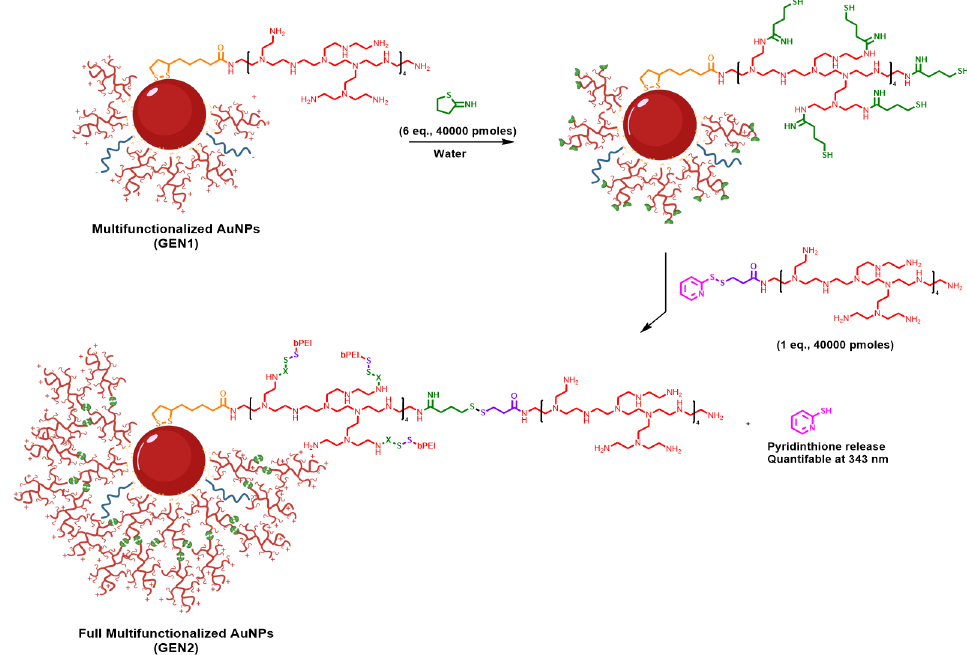
Figure 2. Synthesis scheme of GEN1 AuNPs activation of GEN1 2-iminothiolane to consecutively being functionalized with SPDP-bPEI to obtain GEN2 AuNPs.